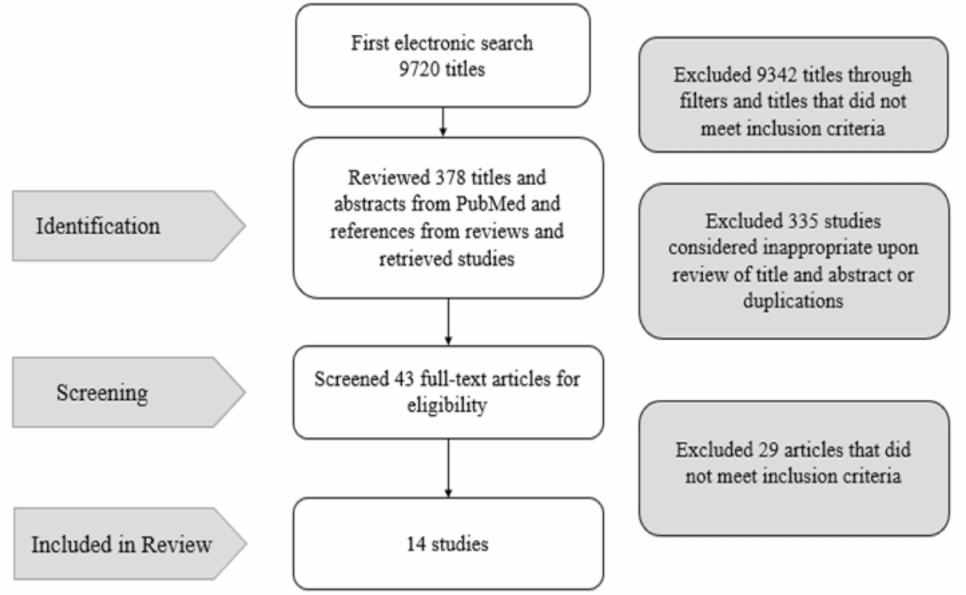
Figure 2. Flow chart of the search